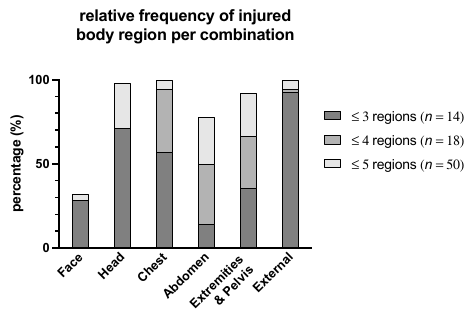
Figure 1. Relative distribution of injured body regions according to ISS per injury combination in prehospital trauma-related deaths.